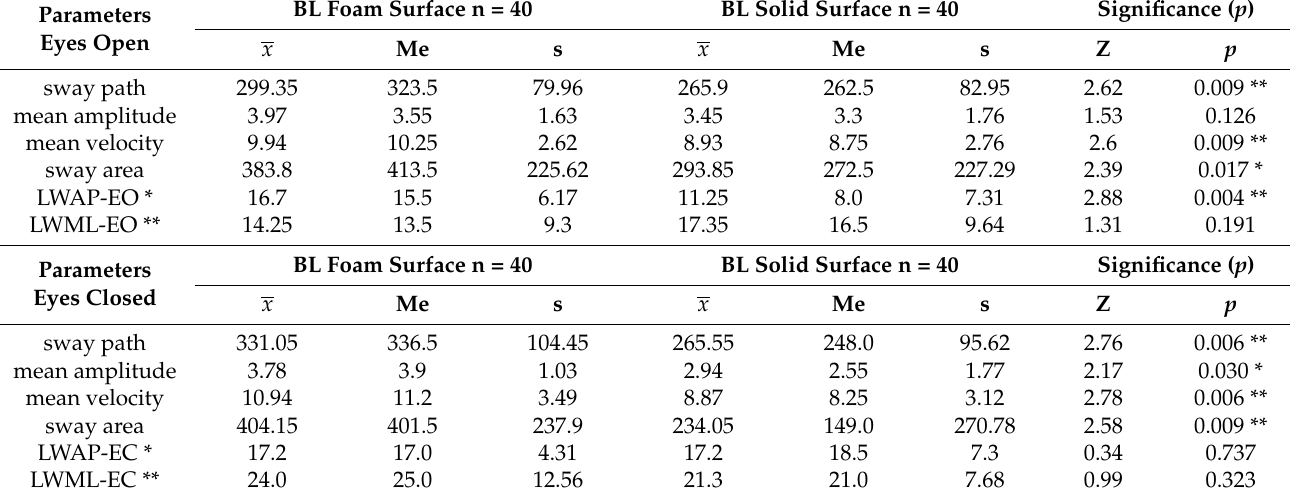
Table 1. Comparison of the results on the platform, foam surface versus solid surface, with eyes open and eyes closed, in the group of blind or partially sighted subjects.